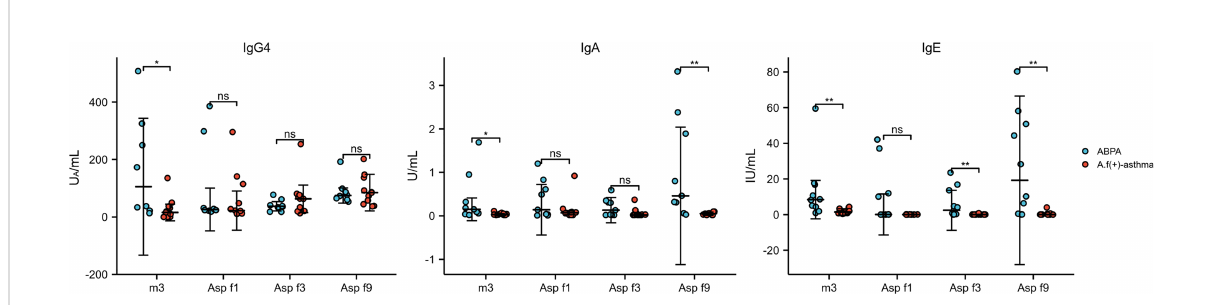
FIGURE 7 The level of IgG4, IgA, and IgE against A.f in different groups. ABPA, allergic bronchopulmonary aspergillosis; A.f (+) asthma, Aspergillus fumigatus -sensitized asthma; m3, crude extract of A.f; Asp f1, Asp f3, and Asp f9, components of A.f ; ns, no signi fi cance; *p<0.05;